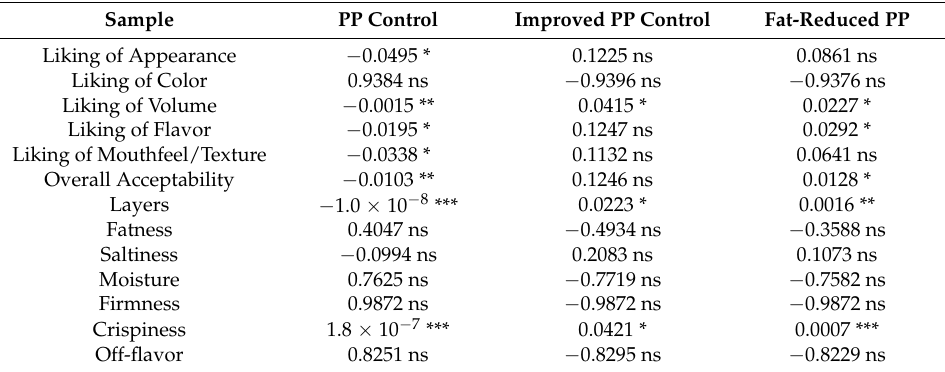
Figure 5. ANOVA-partial least squares regression (APLSR) correlation loadings plot for puff pastry (PP) samples. ▲ = samples, ● = sensory attributes (cursive style: hedonic attributes, not cursive: intensity attributes). Table 6. Significance of regression coefficients (ANOVA values) for the correlation of hedonic and intensity sensory terms for puff pastry (PP) formulations.